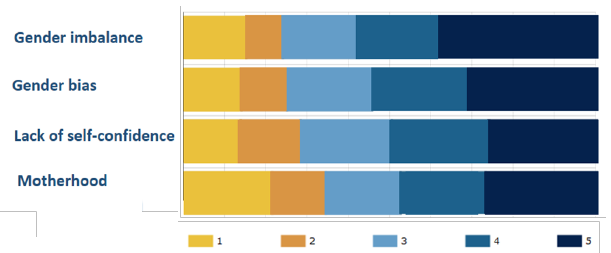
Figure 7. Barriers for women in the EO*GI sector When focusing on barriers experienced during time of education, gender imbalance during study is one of the main barriers identified (average score: 3,58), independent on the women´s profiles. Pressure from family or society to choose another domain/career option are barriers rated relatively low (average score: 1,75, respectively 1.94).